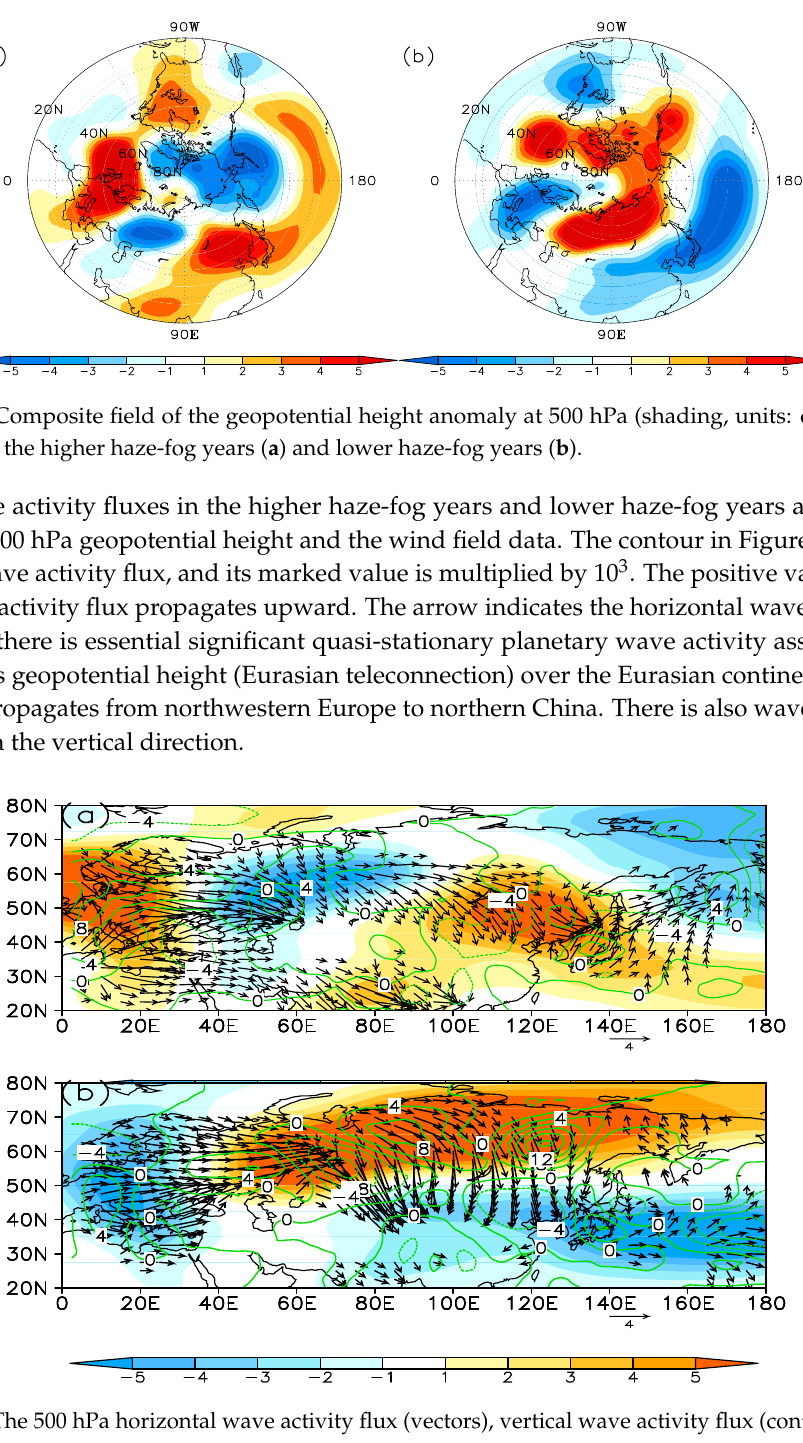
7 Figure 6. Standardized number of haze-fog days from 1980 to 2012.